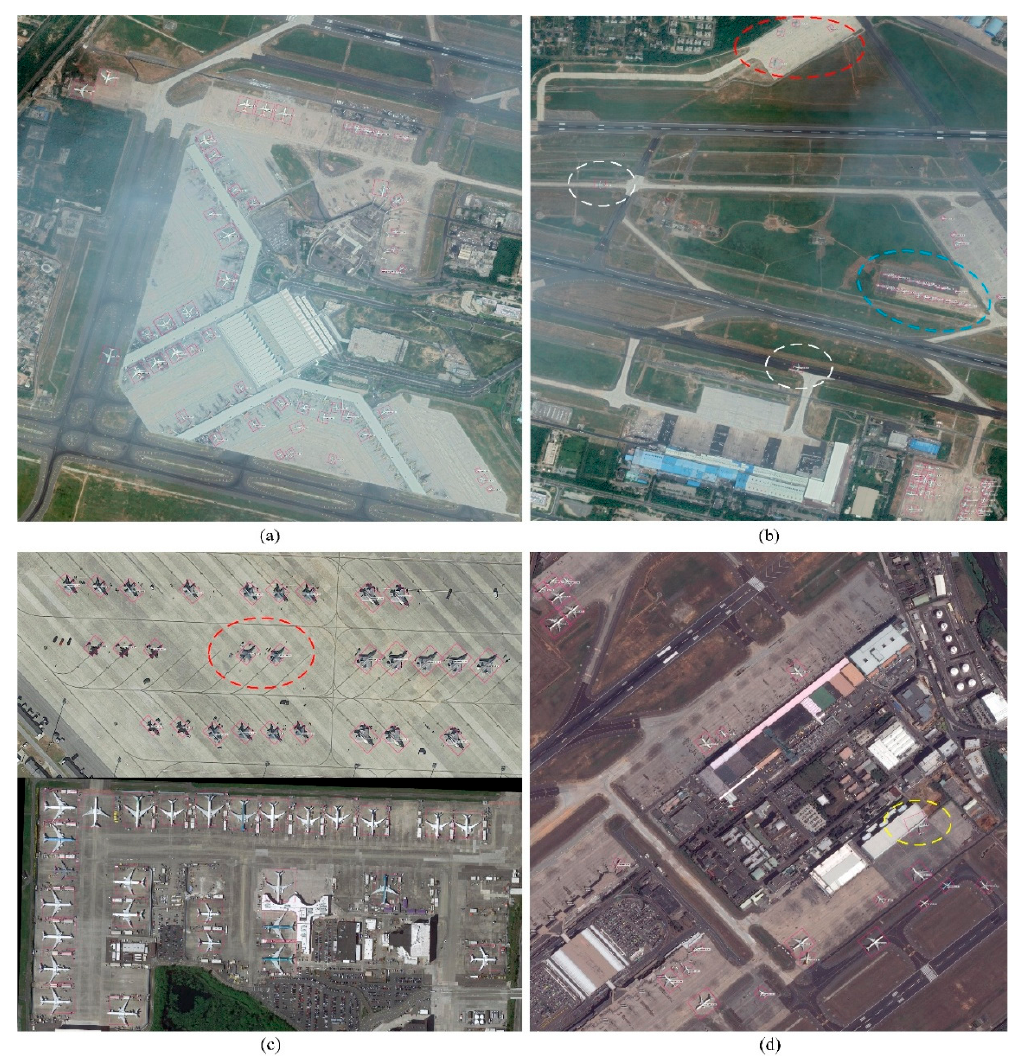
Figure 5. Aircraft detection results (confidence larger than 0.8) in test remote sensing images. (a) Aircraft detection results under thin cloud weather conditions; (b) Aircraft detection results on the apron and runway under thin cloud weather conditions; (c) Detection results of different types of military and civilian aircrafts; (d) Partially occluded aircraft can also be accurately detected.